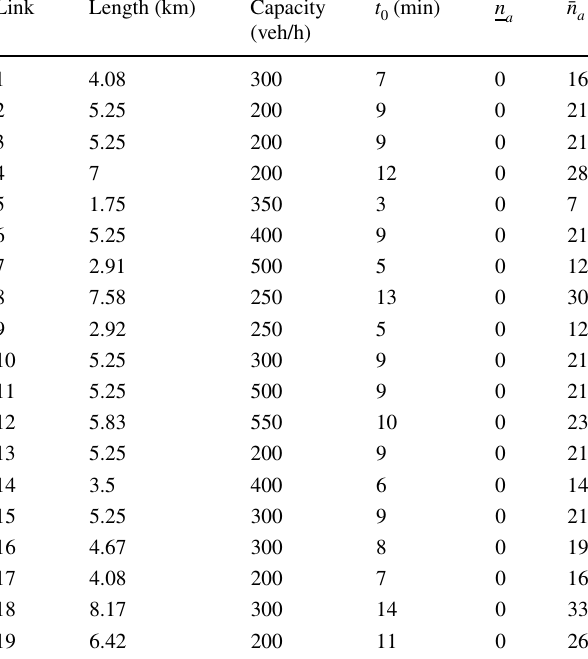
Table 8 Values for link-specific